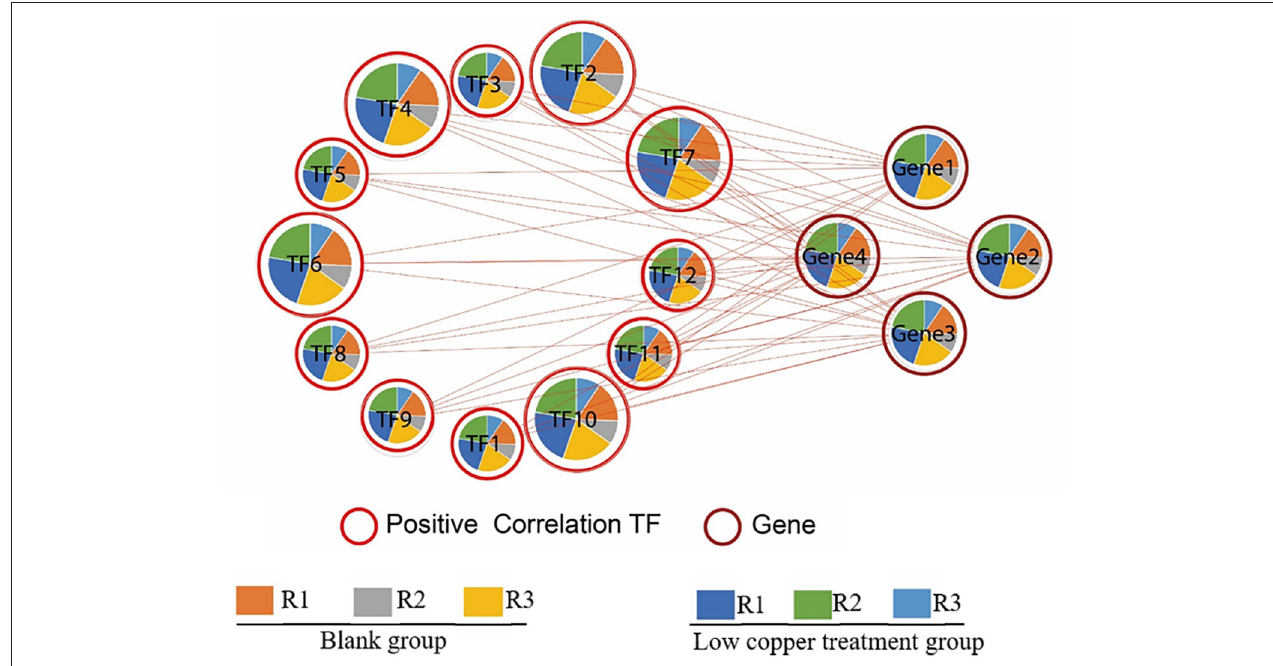
FIGURE 7 | Correlation analysis between significantly changed transcription factors and enzymes related to SalA biosynthesis. The correlation between significantly changed SalA biosynthetic enzymes and the relative expression of candidate transcription factors was analyzed using R software. A Spearman correlation analysis was performed to calculate the correlation